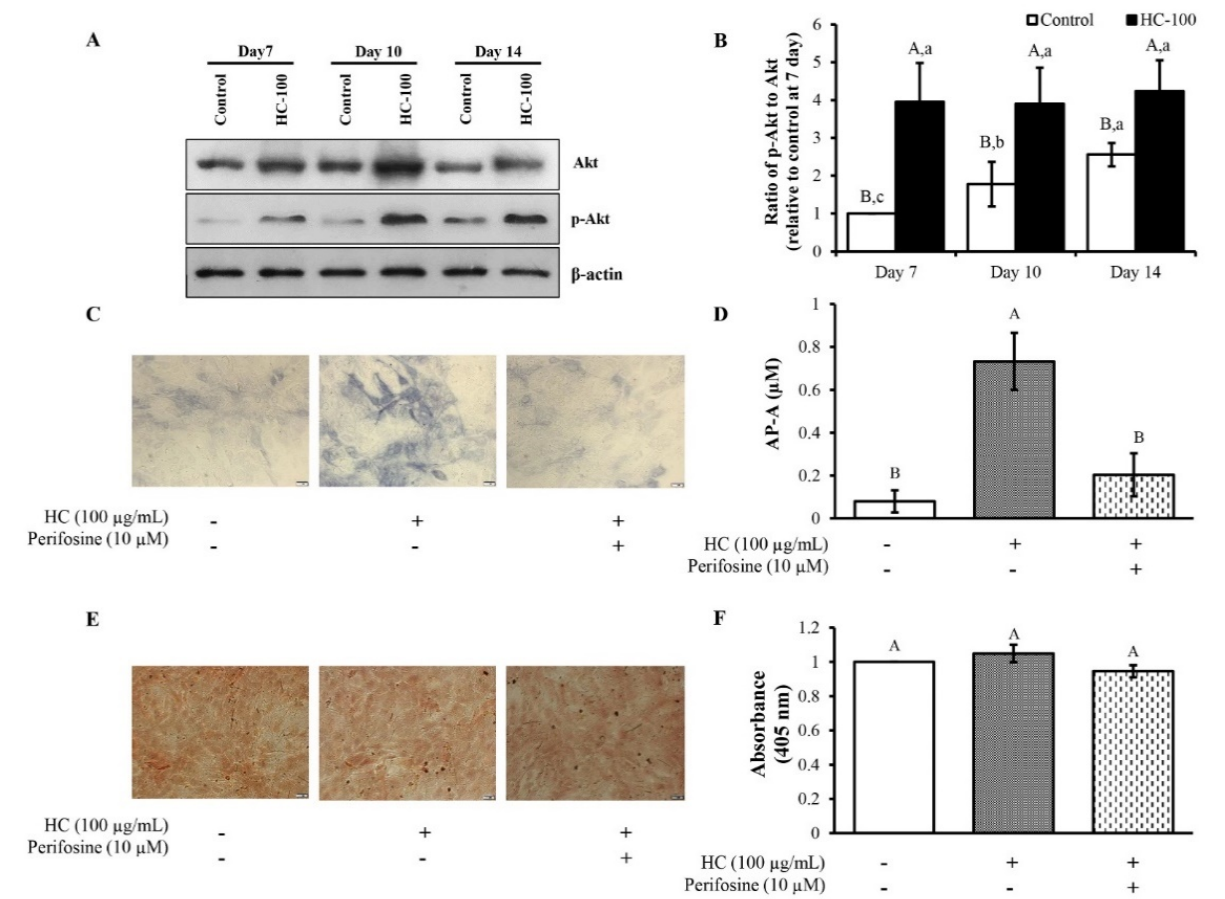
Figure 6. Effect of sea bass skin hydrolyzed collagen (HC) at 100 µg/mL on ( A ) expression of p-Akt, total Akt and β -actin protein expression of MC3T3-E1 cells after differentiation for 7, 10 and 14 days; ( B ) results are expressed as relative value to control at day 7; ( C ) images of blue crystal after staining with BCIP/NBT solution for 1 h; ( D ) alkaline phosphatase activity (AP-A); ( E ) mineralization of cells; and ( F ) changes in absorbance at 405 nm after treatment with or without perifosine (10 µM) for 7 days of differentiation. Error bars represent standard deviation ( n = 3). Different uppercase letters indicate significant differences between samples at the same culture time ( p < 0.05). Different lowercase letters indicate significant differences between culture times of the same sample ( p < 0.05).